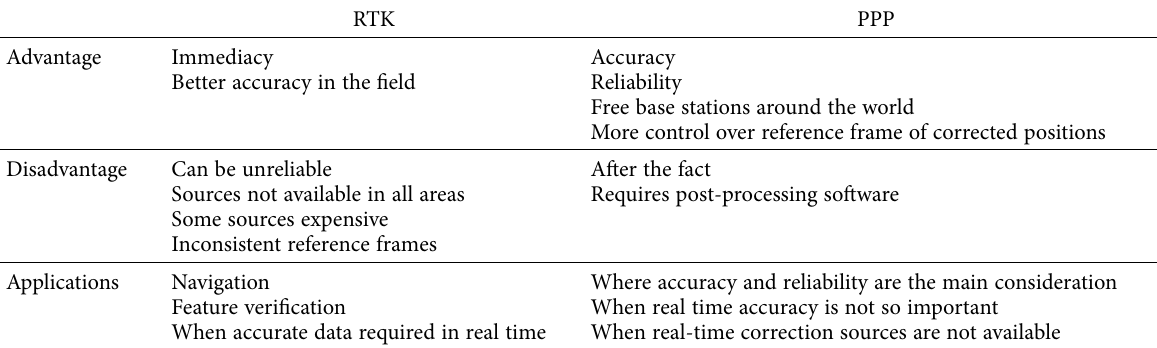
Table 1. Comparison of RTK and PPP (source: table made by the authors) RTK